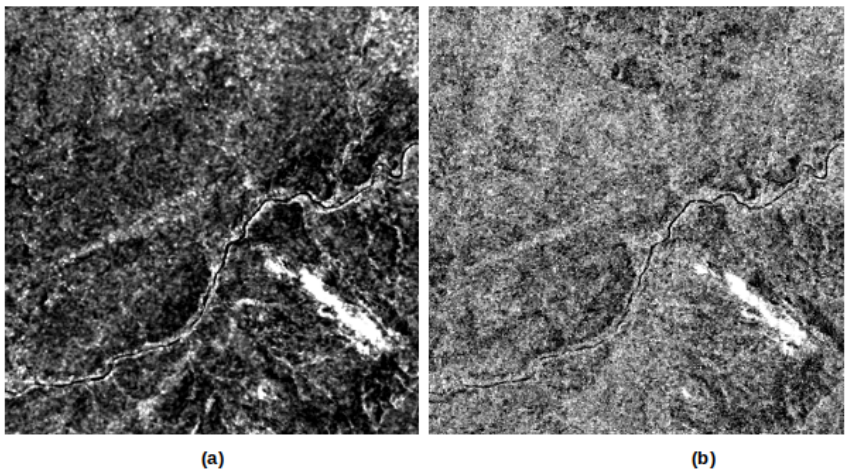
Figure 11. Comparison of filtering approaches on VH bands of BNP images: ( a ) filtering with a multi-temporal filter; ( b ) filtering with a single filter.